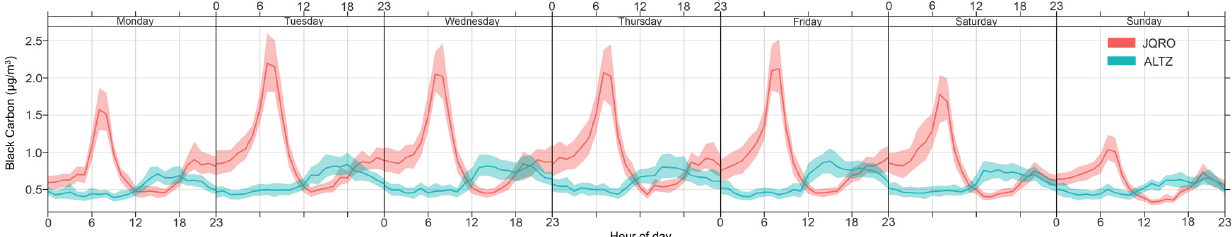
Figure 4. Average weekly profile of BC in JQRO and ALTZ for 2017. The shading highlights the standard deviation.